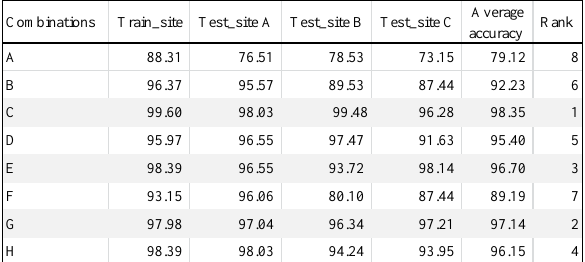
Table 3. Overall accuracy of various feature